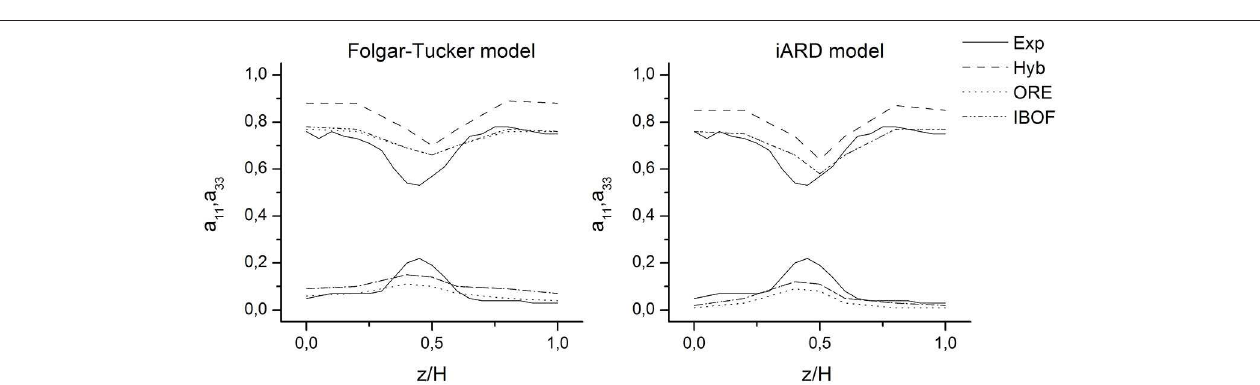
FIGURE 5 | Experimental and predicted a 11 and a 33 profiles at the central region (R2).